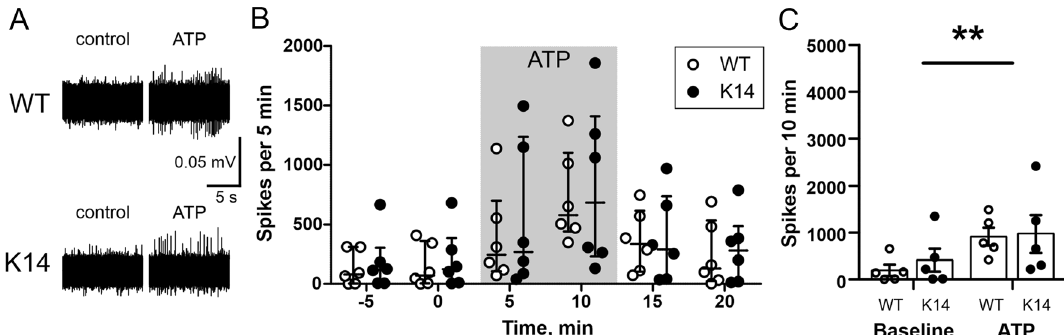
Figure 5. Direct spikes were recorded in WT and K14 hemiskull preparations under basal conditions and ATP stimulation. ( A ) Exemplificative traces of nociceptive spike recordings in WT and K14 animals under basal and ATP-stimulus conditions. ( B ) Number of nociceptive spikes recorded during 5 min bins (median with interquartile range) under basal conditions, during the application of 100 µM ATP, and during the following washout. ( C ) ATP induced a significant increase in nociception activity in both genotypes. ** p = 0.0012 (baseline vs. ATP; n = 6/experimental group) by general mixed-effects model, but no difference was detected between WT and K14 animals ( p = 0.711—genotype effect). Data presented as mean ± SEM.